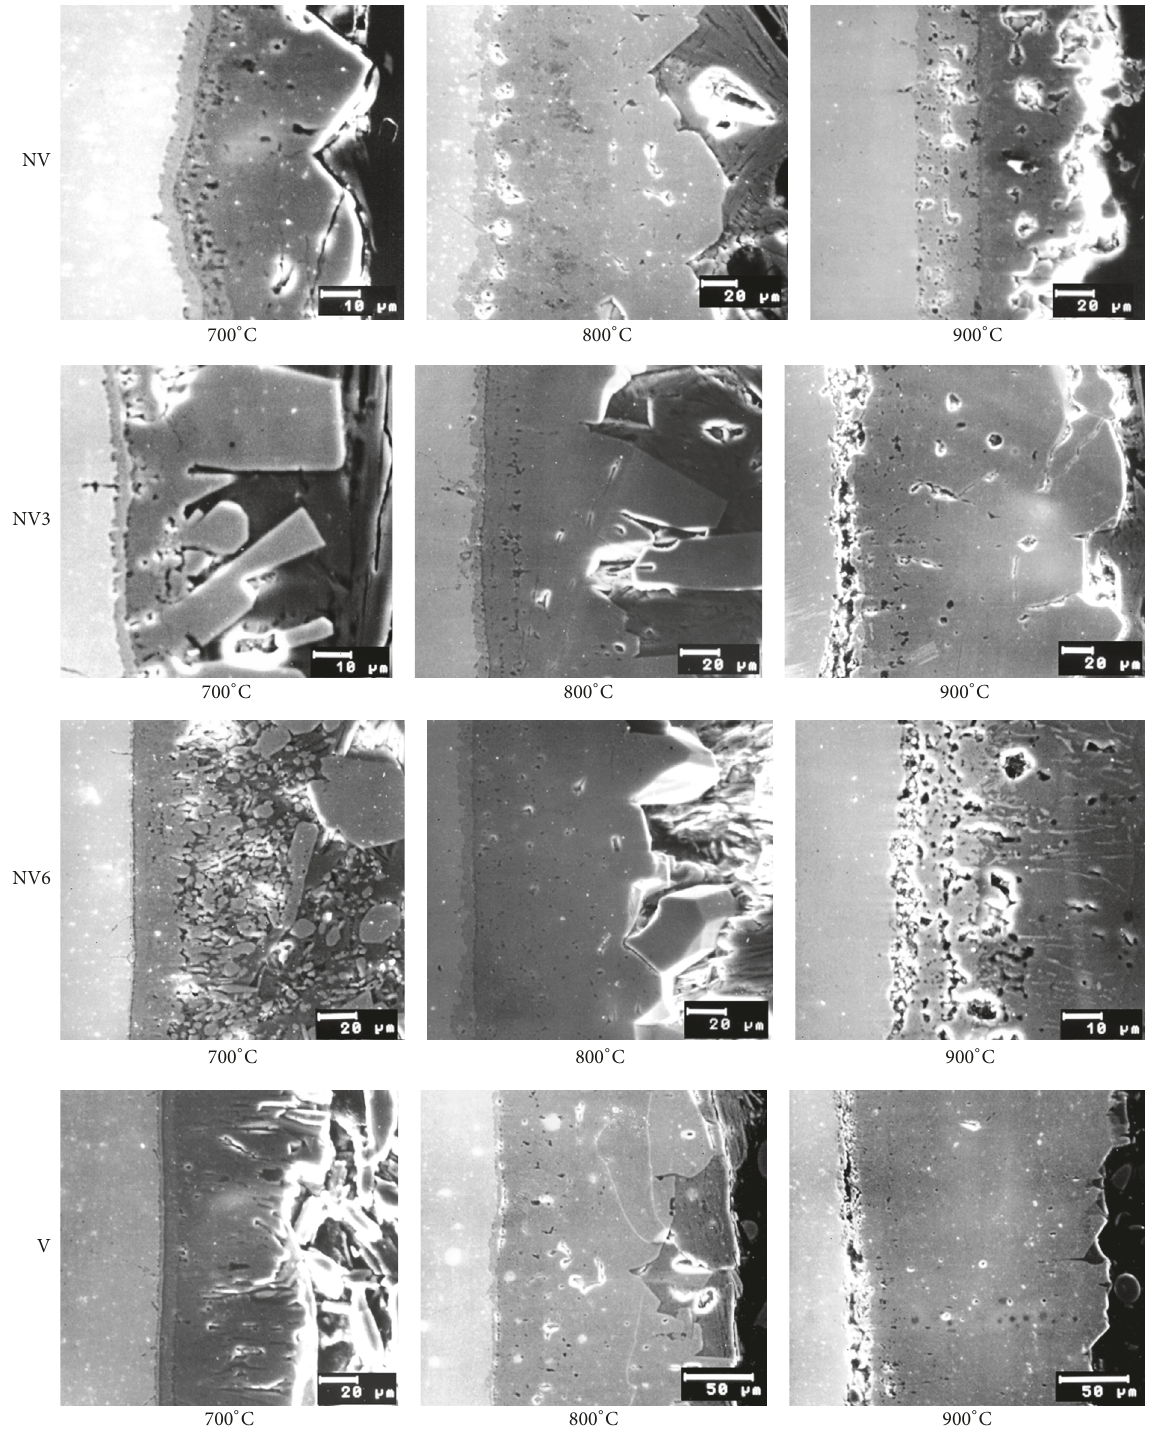
Figure 11: Micrographs of the cross sections of Ni exposed to NV3 at 600, 700, 800, and 900 ∘ C, during 100